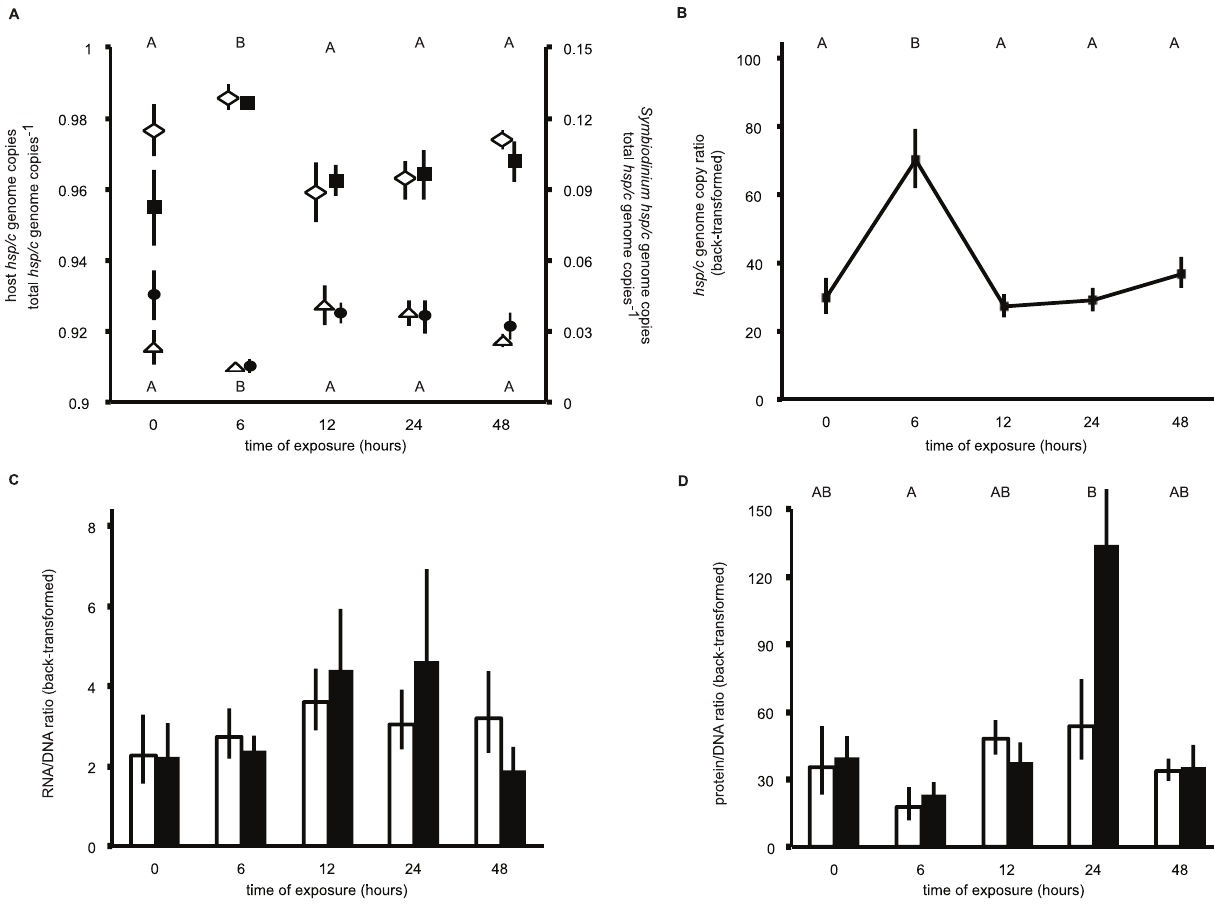
Figure 4. Genome copy proportions (GCP), genome copy ratio (GCR), RNA/DNA and protein/DNA ratios from the thermal stress experiment. (A) Host (left y-axis) and Symbiodinium (right y-axis) hsp/c genome copies as a proportion of the total hsp/c genome copies within the sample (GCP). Hollow diamonds and triangles represent data from the control treatment for the host and Symbiodinium GCPs, respectively. Filled squares and circles represent data from the high temperature treatment for the host and Symbiodinium GCPs, respectively. Tukey’s HSD letter groups ( a , 0.05) above and below icons correspond to the host and Symbiodinium data, respectively, and test only temporal variation, as neither significant treatment nor interaction effects were observed for these parameters. While both host and Symbiodinium GCP appear to differ between treatments at time=0, this difference was not statistically significant (Tukey’s post hoc test, p . 0.05). (B) Mean host/ Symbiodinium hsp/c GCRs pooled across both treatments over time. Tukey’s HSD letter groups ( a , 0.05) are also presented. (C) RNA/DNA ratio over time for both control (white columns) and high (black columns) temperature treatments. (D) Protein/DNA ratio over time for both control (white columns) and high (black columns) temperature treatments. Tukey’s HSD letter groups test only temporal variation, as neither significant treatment nor interaction effects were observed for this parameter. While the protein/DNA ratio appears to differ between treatments at time=24, this difference was not statistically significant (Tukey’s post hoc test, p . 0.05). In all panels, error bars represent standard error of the mean, and for panels B–D, the back-transformed means are